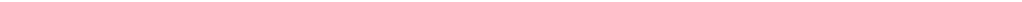
(see fi gure on previous page) Fig. 7 Ninj1 suppresses Caspase-9-dependent intrinsic apoptosis in preOCs, and incremental Ninj1 expression enhances the survival of preOCs. a BMMs were cultured with M-CSF and RANKL for the indicated days. Cell lysates were subjected to immunoblot analysis. b RAW264.7 cells transfected with siScr or siNinj1 were cultured with RANKL. Cells were harvested on the indicated days and subjected to immunoblot assays. c GFP + or DsRed + RAW264.7 cells were transfected with scrambled siRNA or Ninj1 siRNA as indicated. An equal number of each fl uorescence protein-labeled cell population was cocultured with RANKL. The ratio of GFP + to DsRed + cells was determined using FACS, and the data are shown as the mean ± SD ( n = 3, with triplicates in each experiment); ** P < 0.01, and *** P < 0.001. d – f RAW264.7 cells were stably transduced with Ninj1-FLAG or empty vector using a retrovirus and cultured with RANKL. Cells were harvested and stained with APC-Annexin V and 7AAD on the indicated days followed by FACS analysis. d Representative plots showing the results of FACS analysis on days 2 and 3. e FACS-determined statistical stacked bars ( n = 4). f FACS- determined percent frequency of Annexin V + cells. The data are shown as the mean ± SD ( n = 4); ** P <